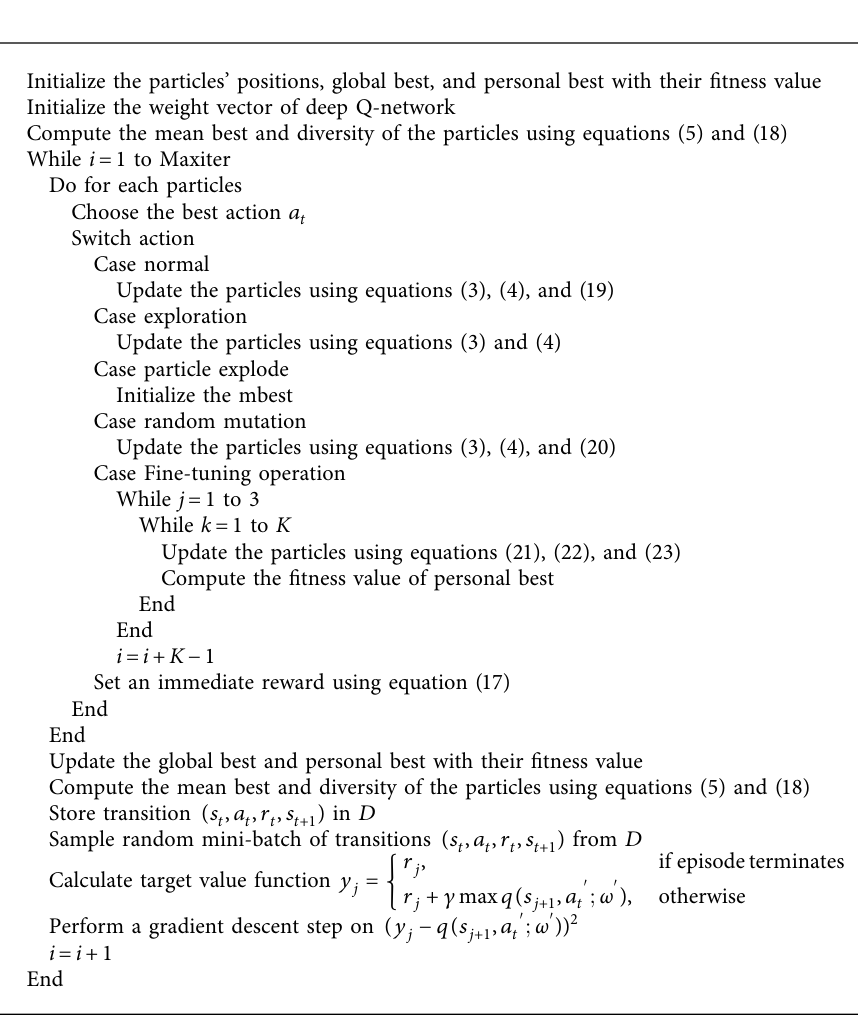
Figure 5: Algorithm structure